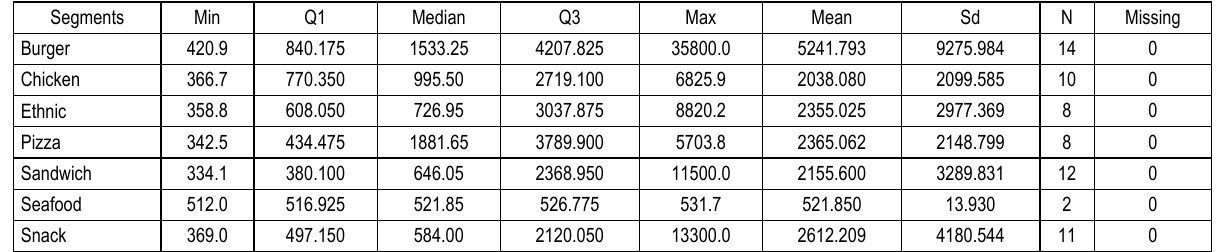
Table 2. Quick service restaurants sales by segment